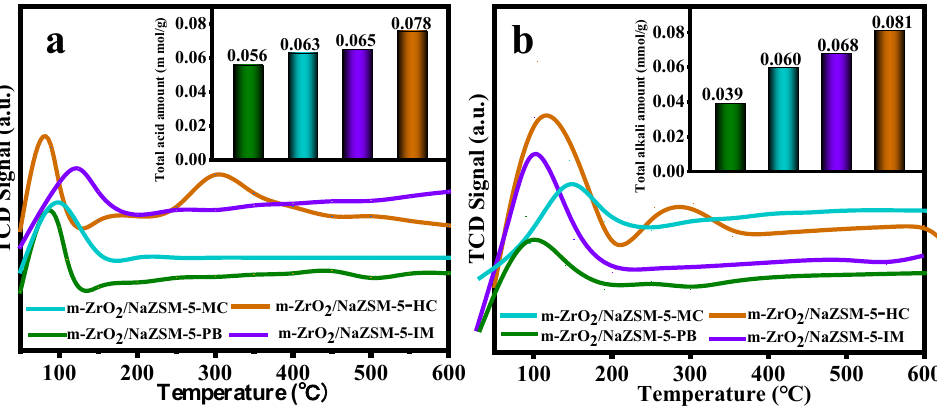
Figure 7. TPD spectra of different composite catalysts: ( a ) NH 3 -TPD and ( b ) CO 2 -TPD.